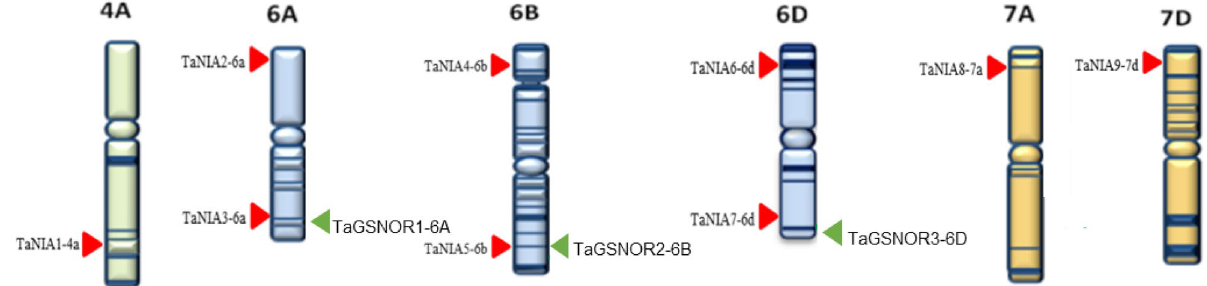
Figure 1. Distribution of the identified 9 TaNIA genes (red arrows) and 3 TaGSNOR genes (green arrows) in the A, B and D homoeologous genomes of wheat. Image created in WGSC website (https:// wheat- urgi. versa illes. inra.